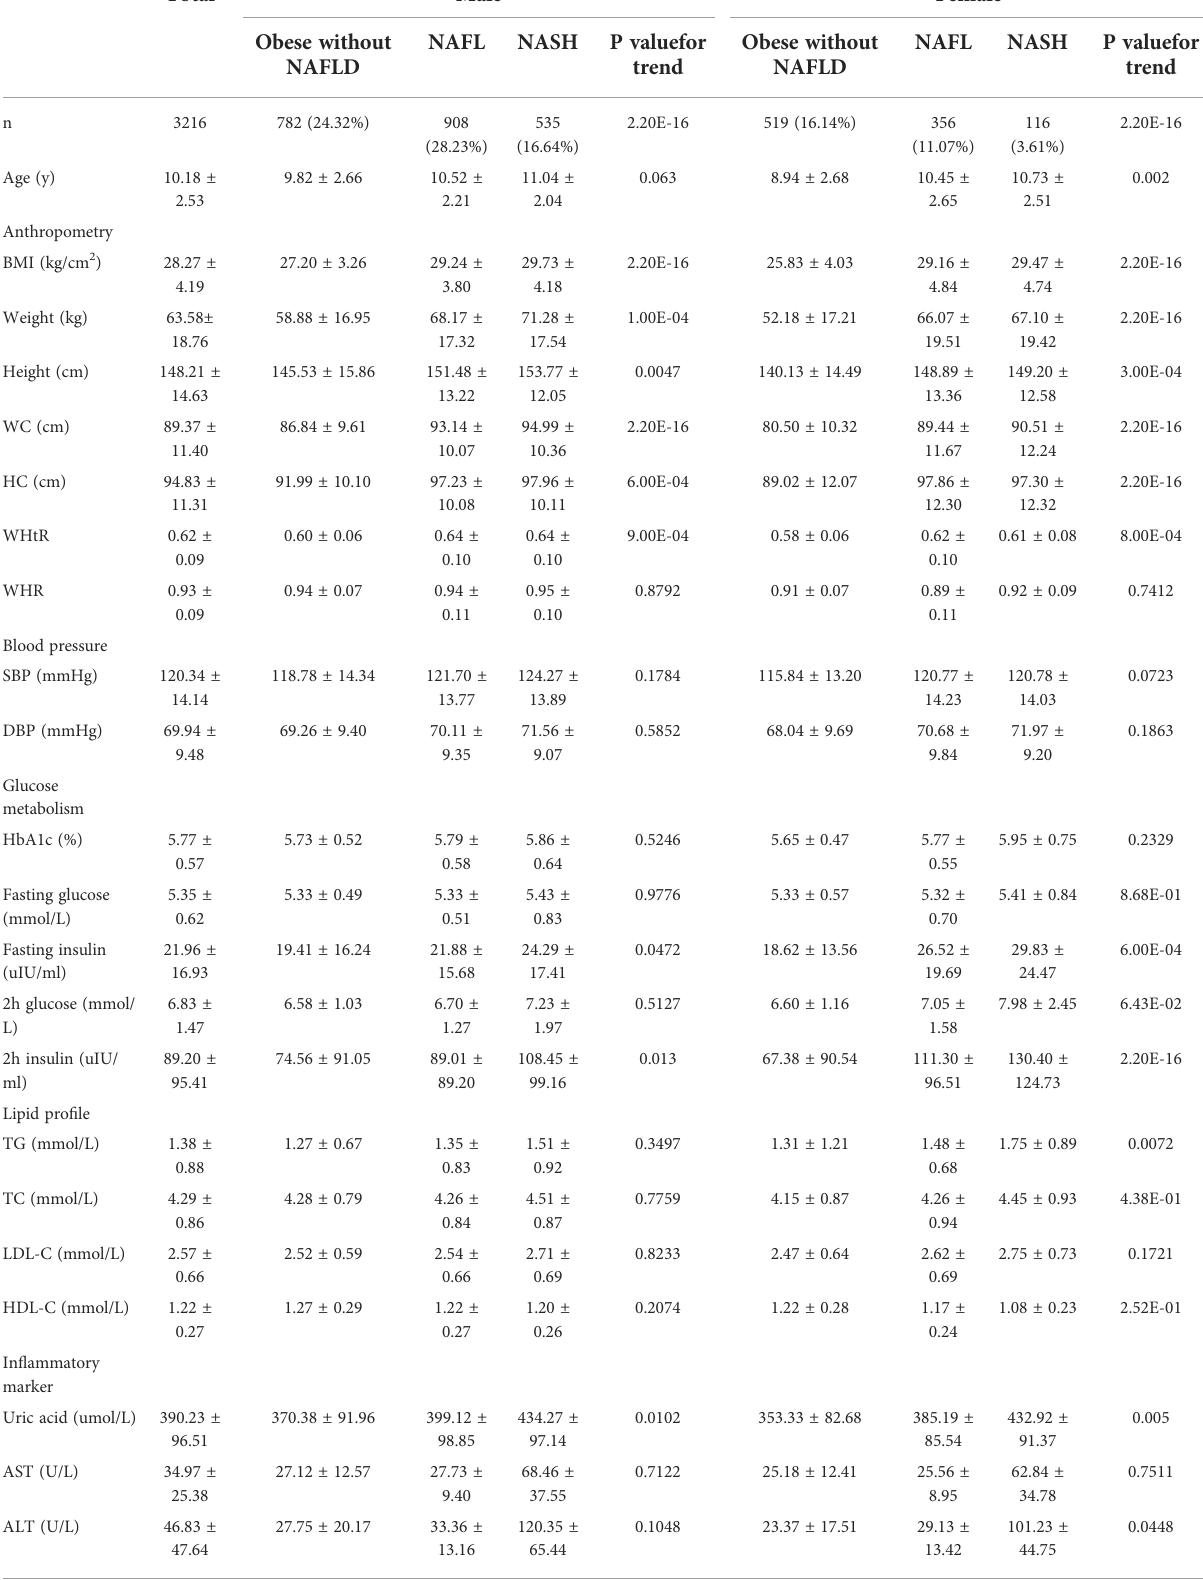
TABLE 2 Clinical features of the participants grouped by gender. Total Male Female Obese without NAFL NASH P valuefor Obese without NAFL NASH P valuefor NAFLD trend NAFLD